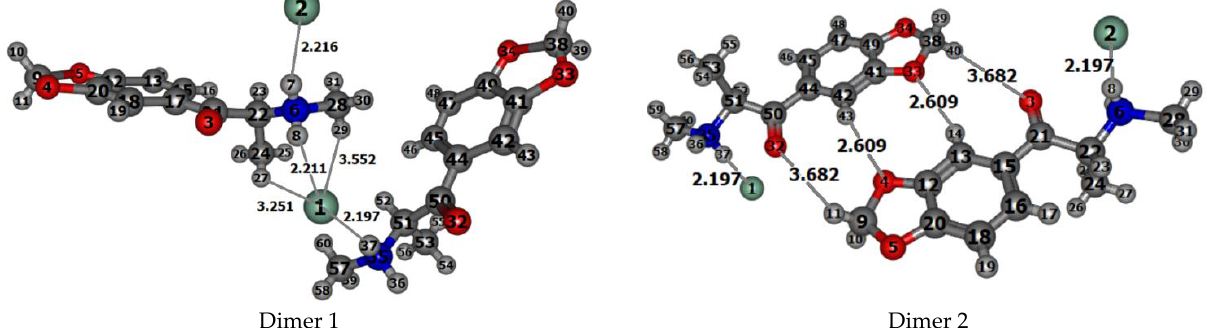
Figure 4. The structures of dimers 1 and 2 of methylone hydrochloride selected from the X-ray crystal data. Selected experimental [46] intra- and intermolecular distances (Å) for the dimers are indicated. The Cl atoms are shown in green, O atoms are in red, N in blue, and C in gray.